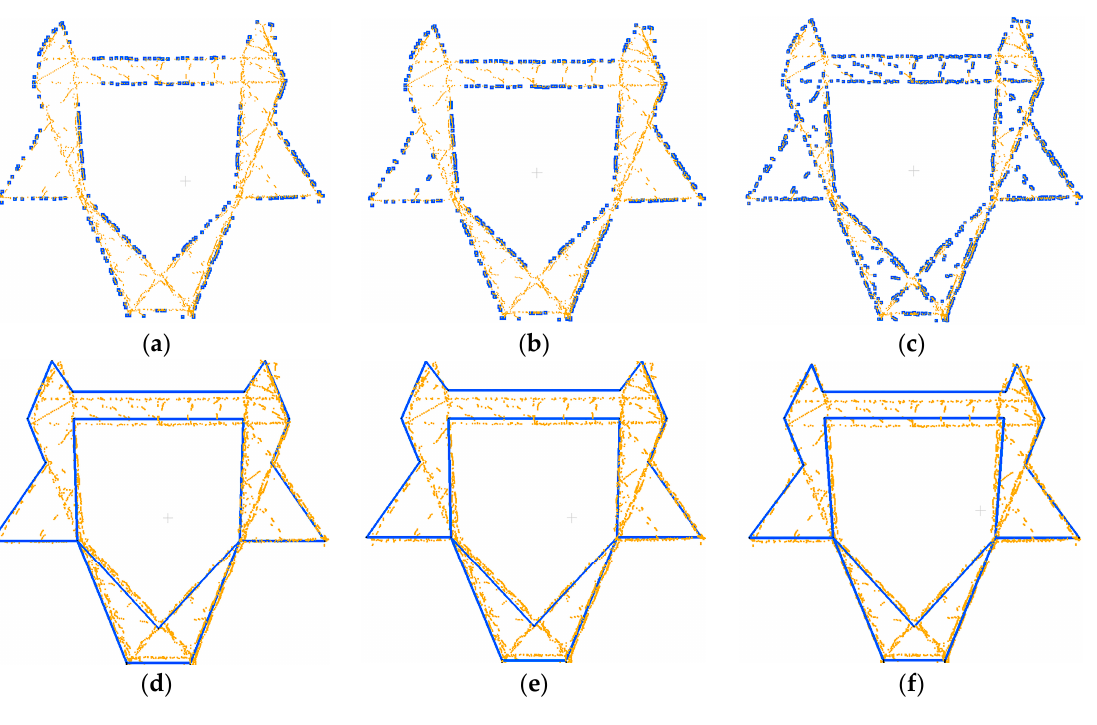
Table 10. Accuracy comparison of three different alpha values.